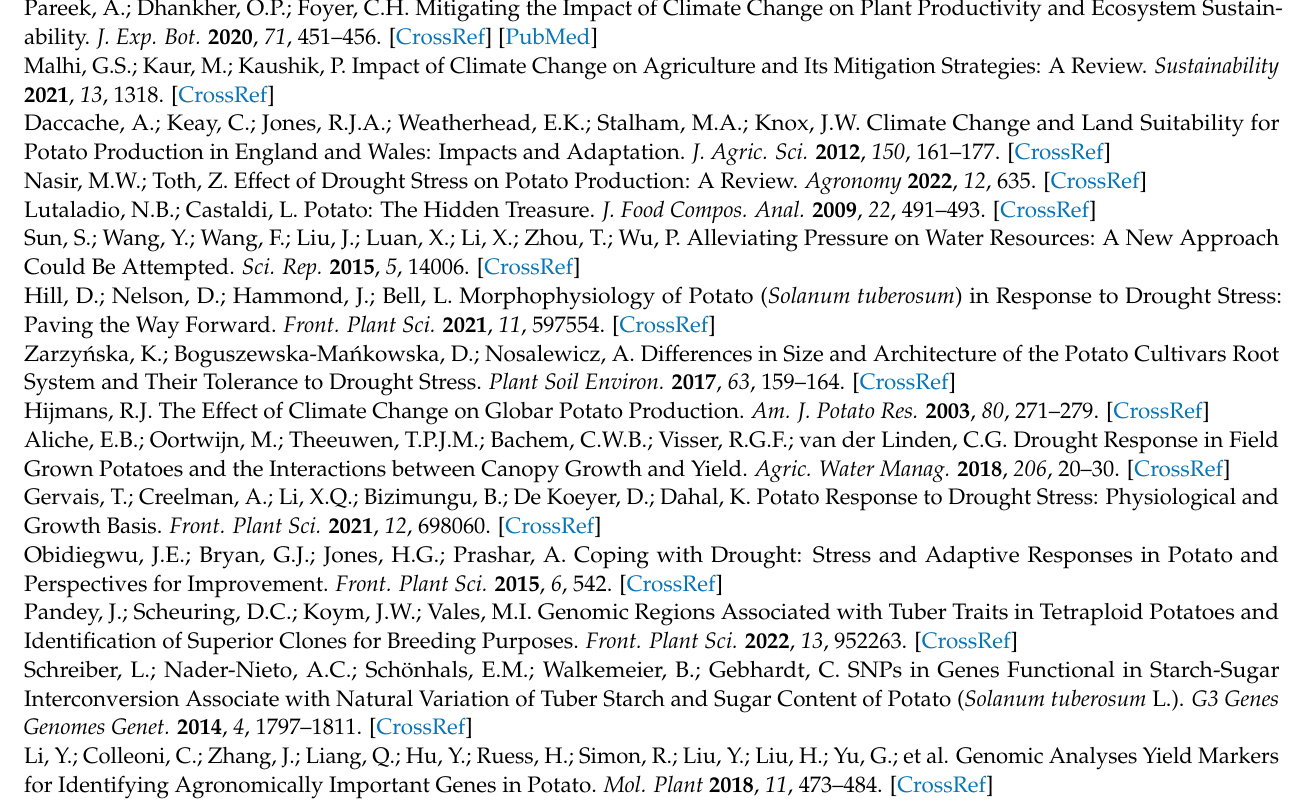
with a delta K = 2. Figure S2: Linkage disequilibrium (LD) decay plot between r 2 and genetic distance. Figure S3: Q-Q plots for all traits evaluated under control and drought stress conditions in 144 potato varieties. Numbers 1 to 12 refer to each of the 12 potato chromosomes, 0 refers to control markers that are not associated with any chromosome, and 13 refers to the